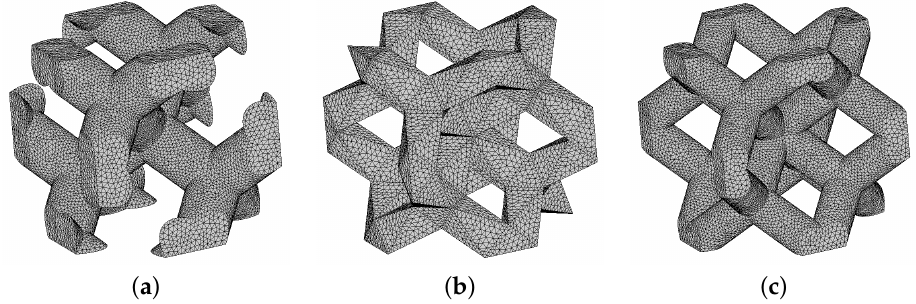
Figure 15. Finite element meshes of basic cells of trabecular structure: ( a ) D30-1, ( b ) DT-1, ( c )